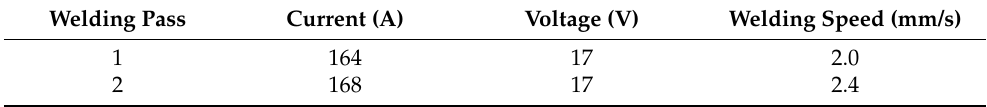
Table 3. Welding